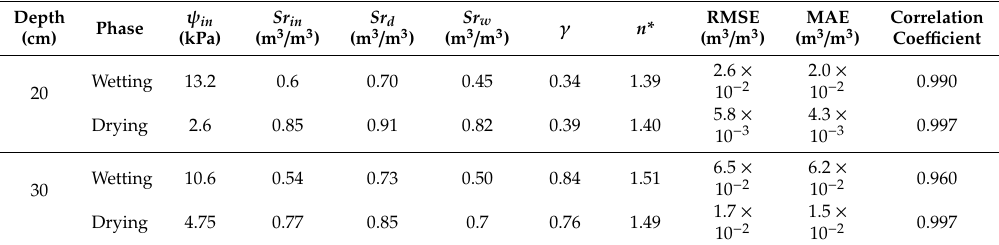
Table 4. Values of the parameters adopted for the validation procedure and error statistics.